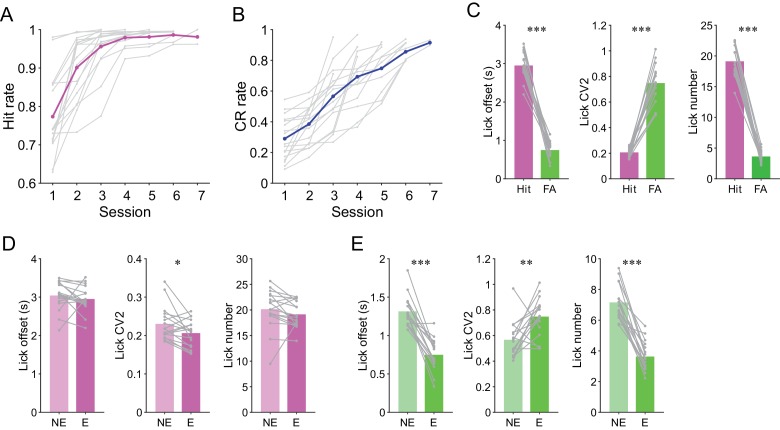
Analyses of task performance and licking behavior.(A) Learning curves for hit rate in all mice (n = 17). Gray dots and lines represent individual animals and magenta dots and line represent means. (B) Same as panel (A) but for CR rate. Gray dots and lines represent individual animals and the blue line and dots represent means. (C) Mouse-averaged lick offset, lick CV2, and lick number for hit and FA trials (n = 17 mice). (D) Mouse-averaged lick offset, lick CV2, and lick number for hit trials in non-expert (NE) and expert (E) performance sessions (n = 17 mice). (E) Same as panel (D) but for FA trials. (C, D, E) Paired t-test: *p<0.05, **p<0.01, ***p<0.001.10.7554/eLife.47021.004Figure 1—figure supplement 1—source data 1.Datasets used to create Figure 1—figure supplement 1.